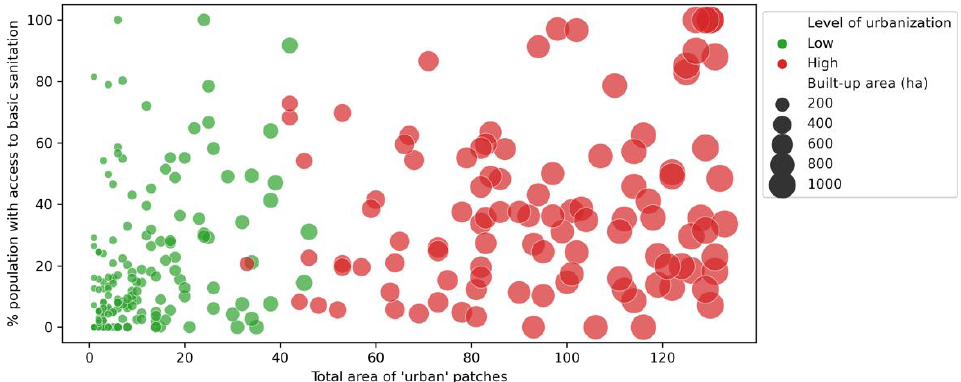
Figure 7. Relationship between the size of the urbanised area ( x -axis) and access to basic sanitation facilities ( y -axis), by level of urbanisation (urban subset shown in red). Elaborated by the authors.